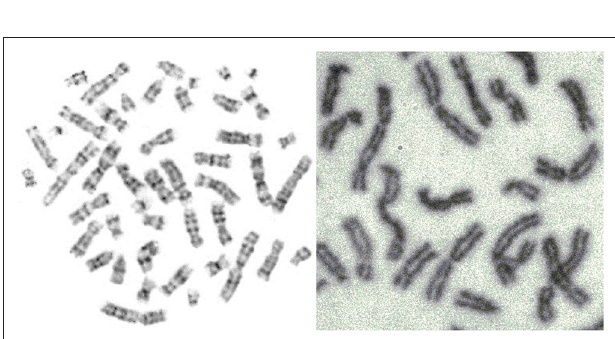
FIGURE 4 | (Left) : fast EEG; (Right) : very fast firing of a neuron (Jovanovi´c, 2001; Jovanovi´c et al., 2014).